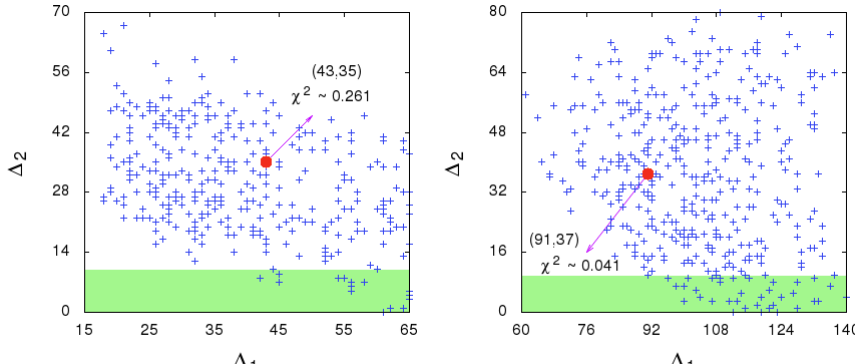
Figure 12 . Plots of the wash-out parameters (cid:1) 1 and (cid:1) 2 for inverted light neutrino mass ordering for both the cases. The red dot corresponds to the corresponding (cid:31) 2 (cid:12)nal baryon